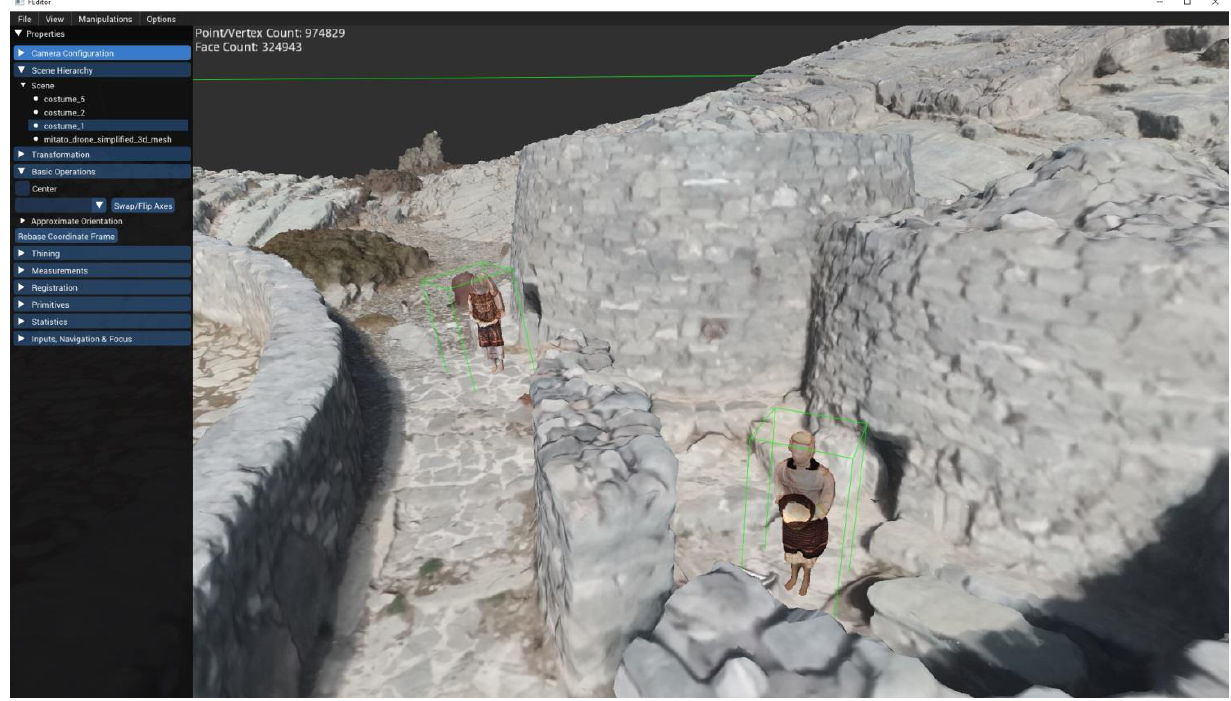
Figure 4. Combining 3D reconstructions to create a synthetic environment using ICombine3D edi- tor.